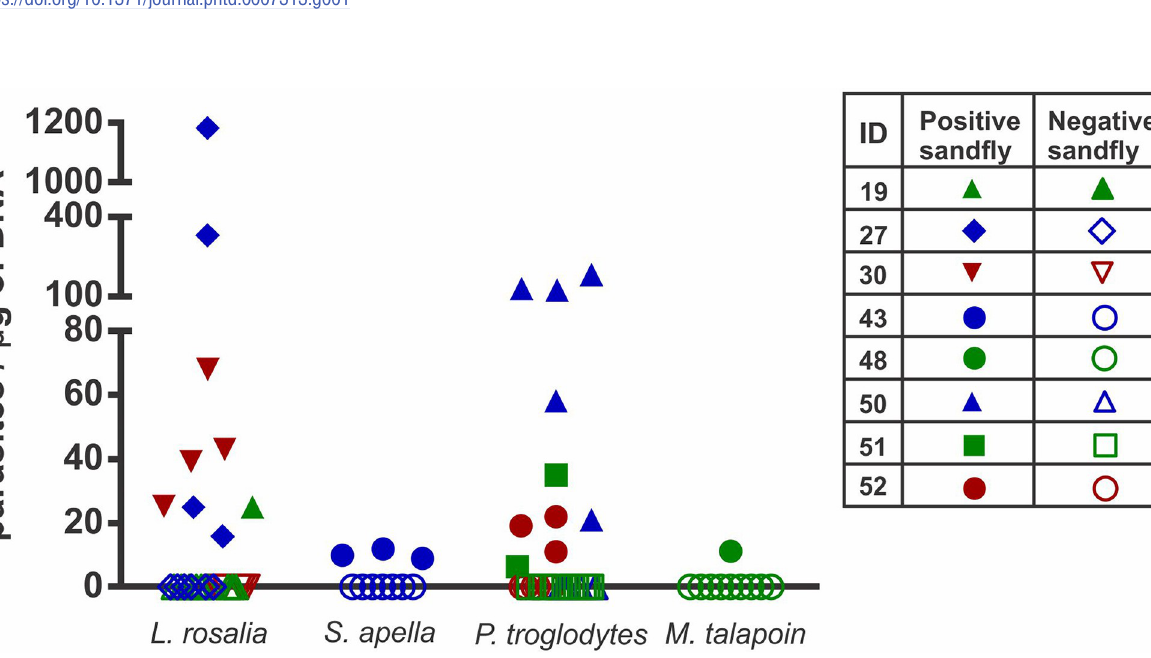
PLOS NeglectedTropical Diseases | https://doi.org/10.1371/journal.pntd.0007313 April 17,